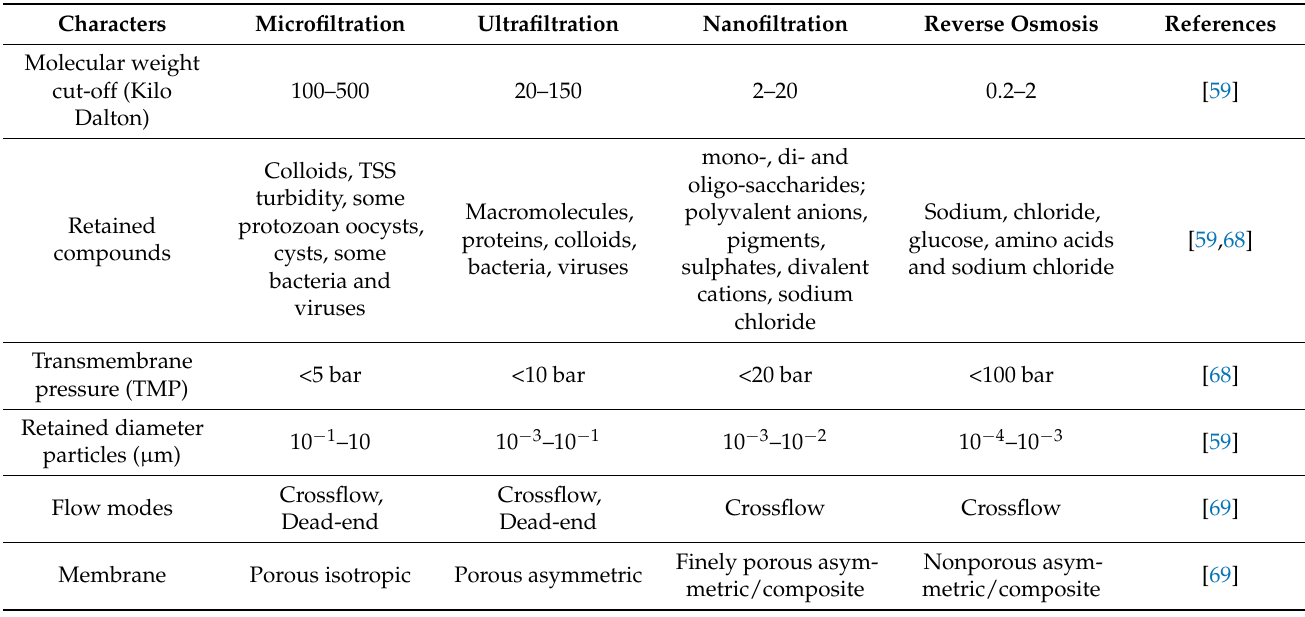
Table 1. Properties of different membrane filtration